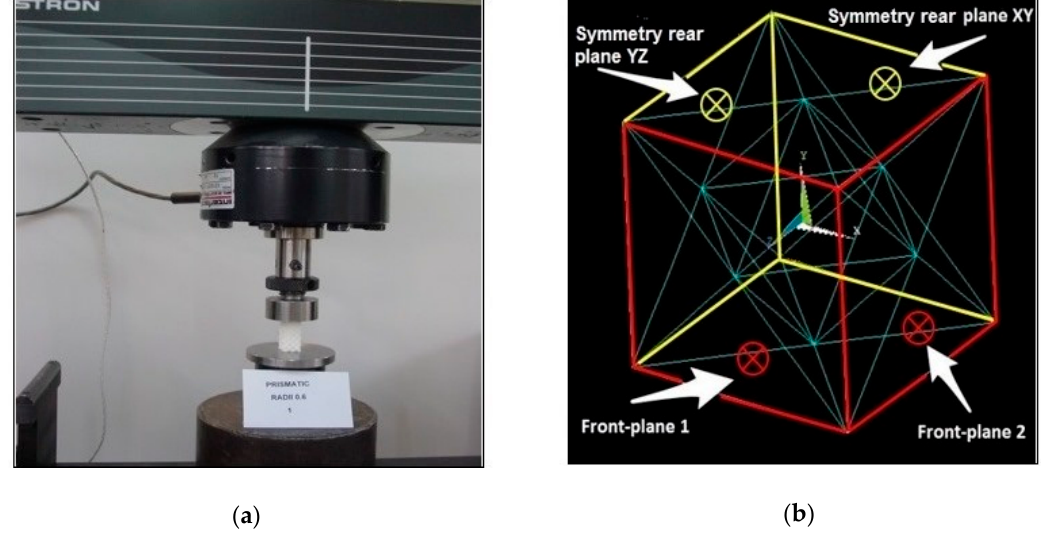
Figure 2. ( a ) A view of the compression test on a toggle-false sample with radii of struts 0.6 mm; ( b ) The structure of the octet-truss modelled with Ansys.